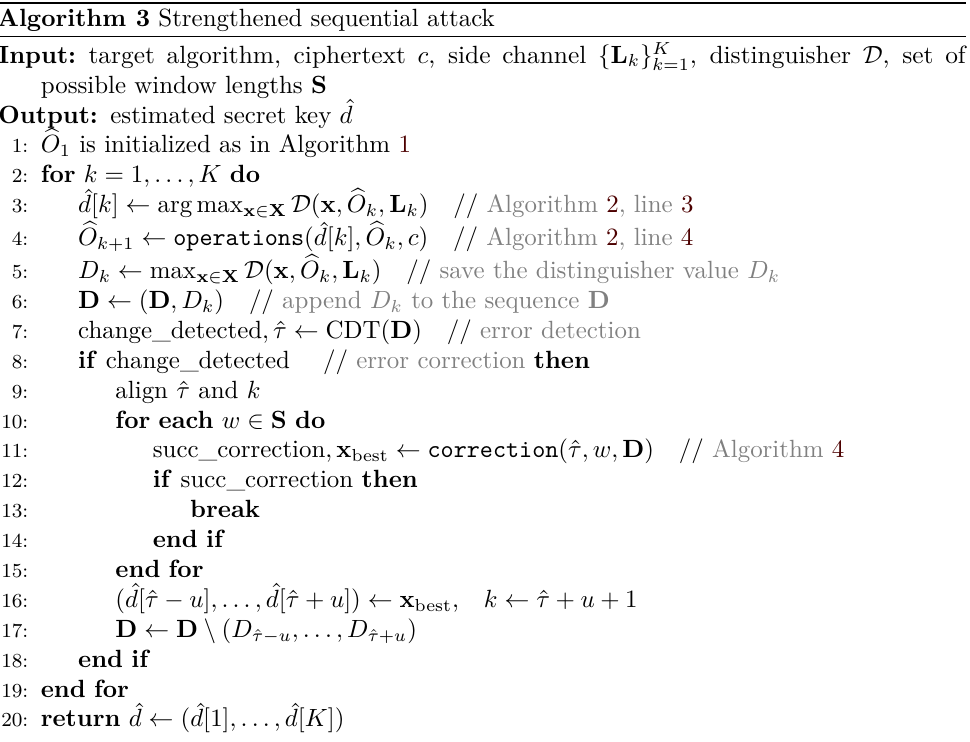
Algorithm 3 Strengthened sequential